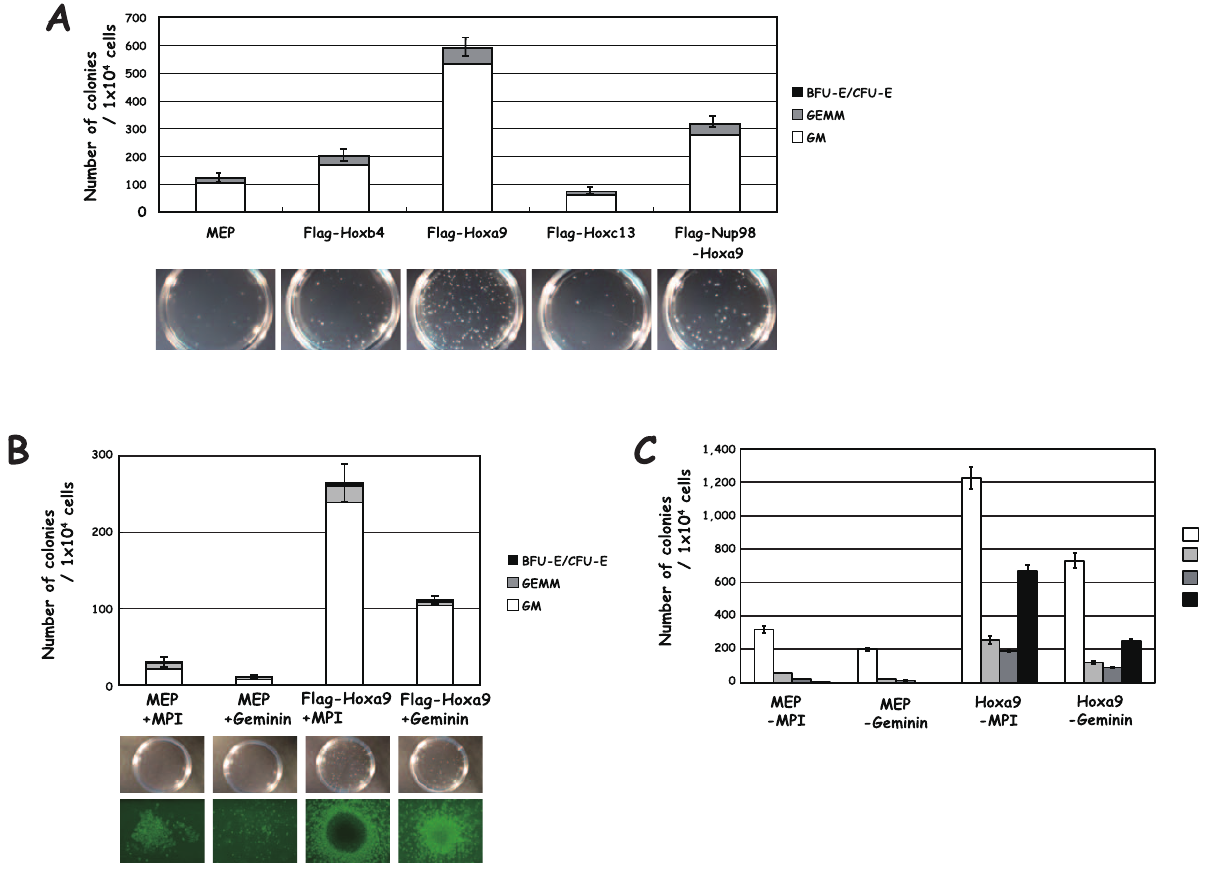
Figure 6. Effect on clonogenic activity. ( A ) Effect of transduction of Hox derivatives on clonogenic activity. Numbers and types of colonies are shown in the upper panel, and close-up photographs of representative colonies in the lower panel. ( B ) Effect of Geminin supertransduction on Hoxa9 transduction-mediated induction of clonogenic activity. Numbers and types of colonies are shown in the upper panel. Close-up photographs of representative colonies and images obtained with an inverted microscopy are shown in the lower panel. A cell cluster with more than 20 cells was counted as a colony under microscopy. ( C ) Effect of Geminin supertransduction on Hoxa9 transduction-mediated induction of replating activity. MEP and MPI, empty control vectors.